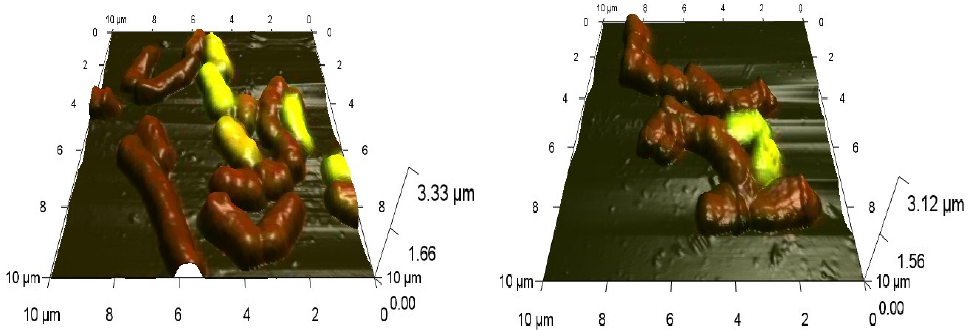
Figure 4. Combined CLSM-AFM images of R. ruber IEGM 231 cells in control ( left ) and after 48-h incubation with 1.0 g/L Ni NPs ( right ). Viable cells fluoresce green, dead cells red.